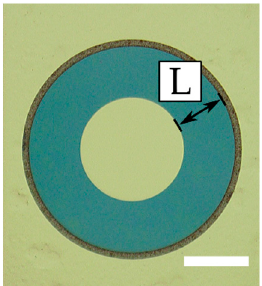
Figure 2. Microscope image of the fabricated Schottky barrier diode (SBD): L is the separation between the Ohmic and Schottky contacts. The scale bar is 50 μ m.